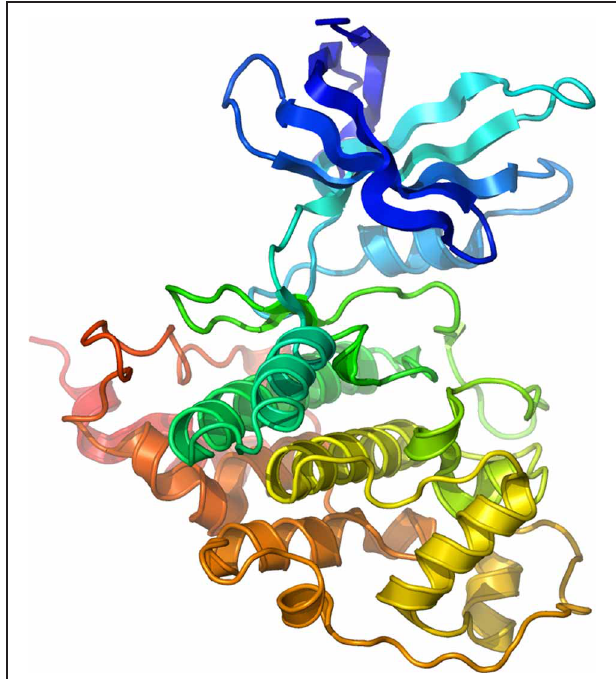
FIGURE 1 | Structure of Human GSK-3 β . Secondary structure model of human GSK-3 β rainbow colored from the N-terminus (blue) to the C-terminus (red). Courtesy of Dr. Lawrence